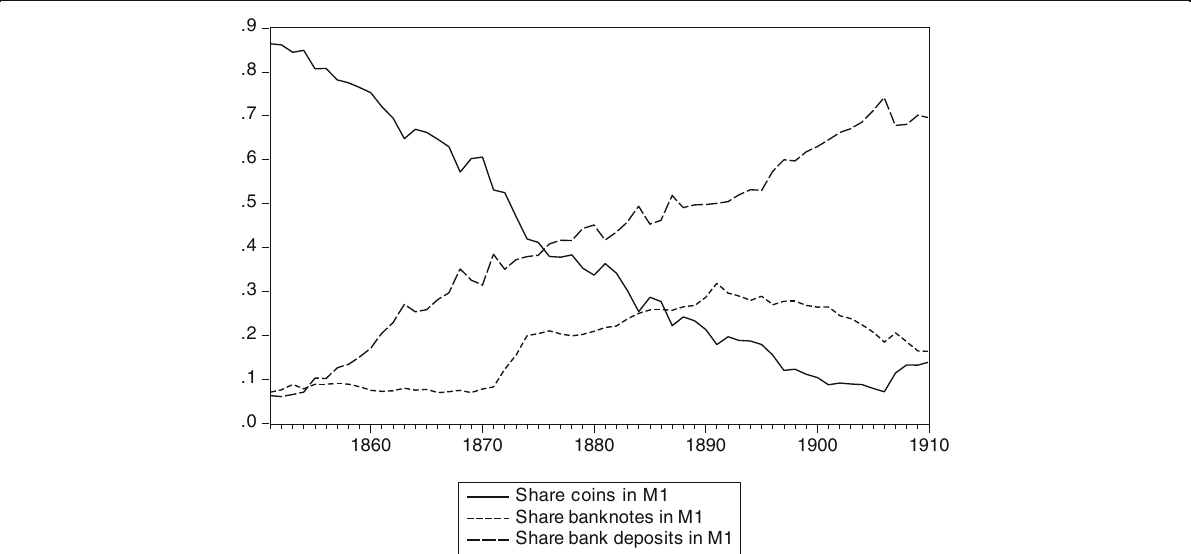
Fig. 1 The composition of M1 in Switzerland 1851 – 1906. Data source: Swiss economic and social history database: M1 1851 – 1907 (Table Q3),